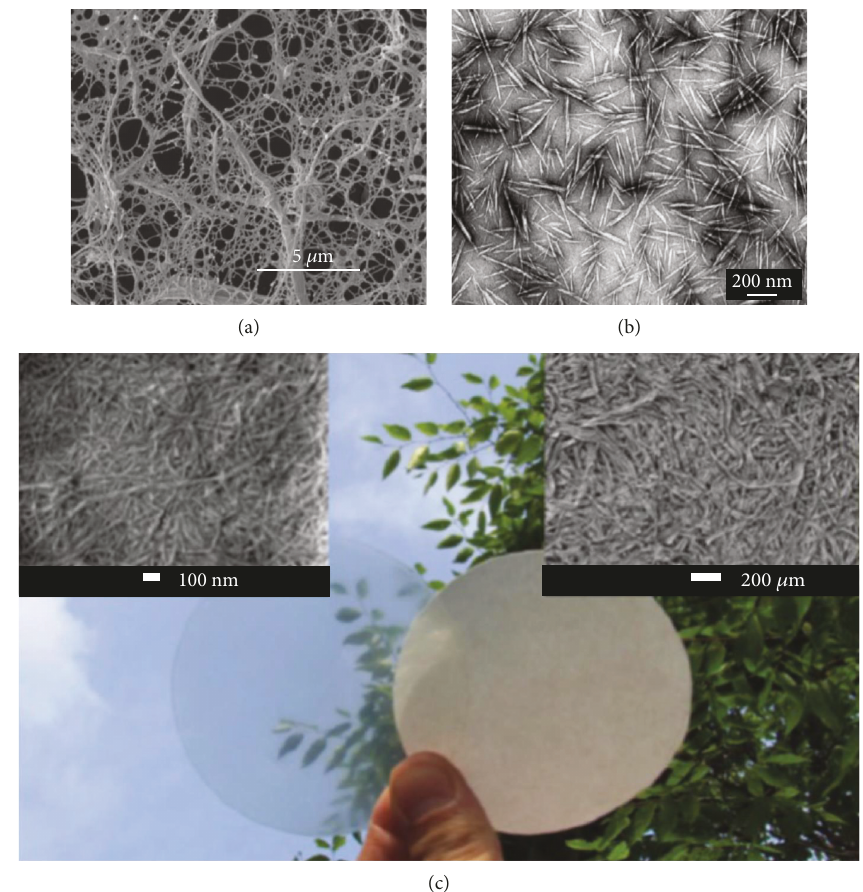
Figure 1: (a) FE-SEM micrograph of cellulose nano fi bres (CNFs) obtained by a mechanical disintegration process with a high-pressure homogenizer from oat straw. Scale bar: 5 μ m. Reproduced from cellulose, reference [17], with permission from Springer. (b) TEM micrograph of cellulose nanocrystals (CNCs) with 6-8 nm diameter and 150-250 nm length, obtained from puri fi ed ramie fi bres by H hydrolysis. Scale bar: 200 nm; reproduced from the Journal of Materials Chemistry, reference [18], with permission from the Royal Society of Chemistry. (c) Nanopaper (left) and fi lter paper (right) comparison. Optically transparent CNP (left) is composed of 150nm long CNCs. The upper left inset, with a scale bar of 100nm, shows a SEM micrograph of the surface of transparent nanopaper. Conventional cellulose paper (right) consists of pulp fi bres with 30 μ m diameter. The upper right inset, with a scale bar of 200 μ m, shows the SEM micrograph of the surface of a sample of fi lter paper. Reproduced from Advanced Materials, reference [13], with permission from John Wiley and